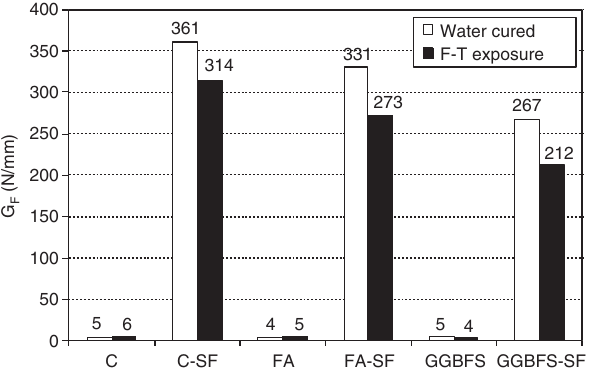
Figure 9 Fracture energy values for water curing and F-T exposure.